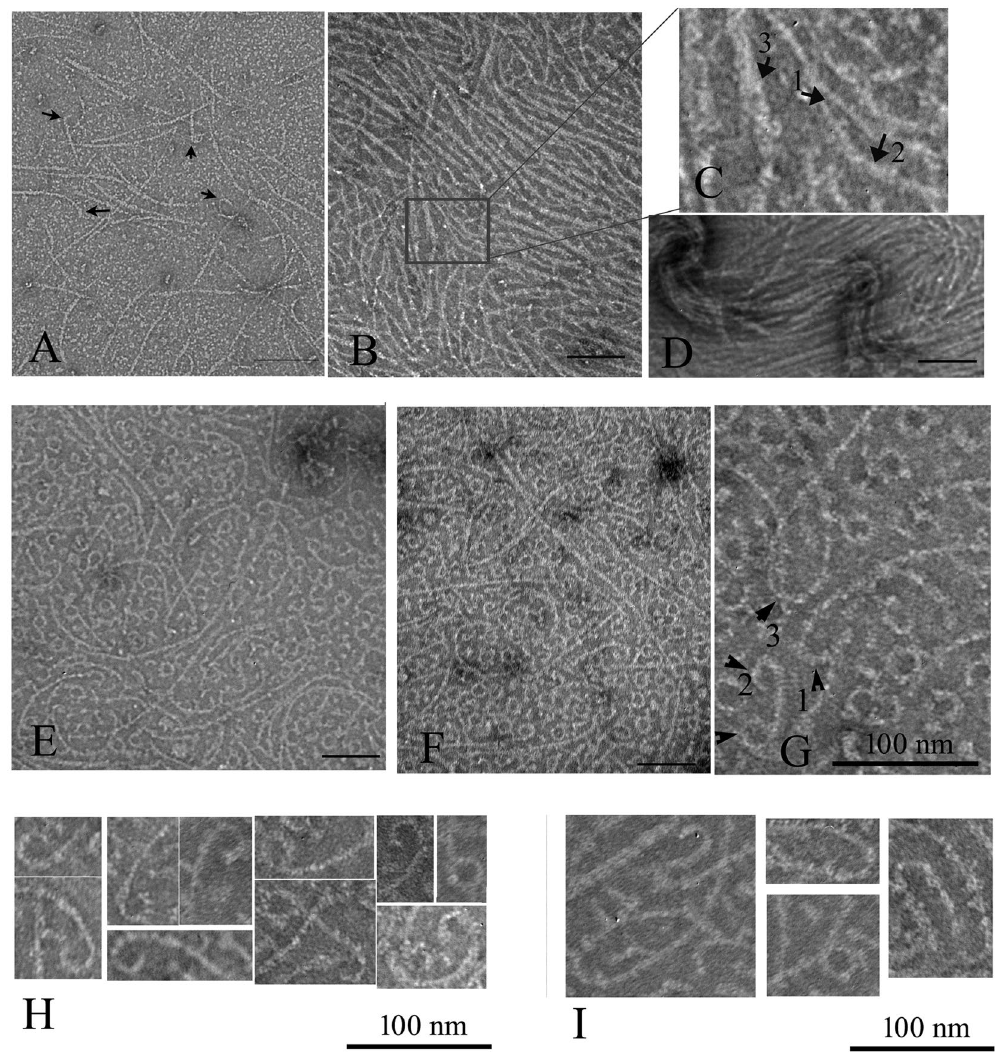
Figure 1. Electron microscopy (EM) images of FtsZ-ZipA at pH 6.5 and 7.5. ( A ) 5 µ M FtsZ only, at pH 7.5. Polymers are mostly single straight filaments, with some short curved segments at the ends (arrows). ( B – E ) At pH 6.5, 5 µ M FtsZ plus 5 µ M ZipA assembles mostly into bundles ( B – D ). In ( C ) arrows identify FtsZ single filaments (arrow 1) and FtsZ-ZipA bundles of variable thickness (arrow 2 and 3). Some areas show single filaments mixed with highly curved filaments and minirings ( E ). ( F – G ) At pH 7.5, 5 µ M FtsZ plus 5 µ M ZipA assembles into single filaments and bundles, mixed with many highly curved filaments and minirings. The highly curved filaments locate mostly at the end of filaments (G, arrow 1), sometimes at both ends ( G , arrow 2), or rarely in the middle of the filaments ( G , arrow 3). ( H – I ) Selected EM images of the highly curved filaments at the end of filaments ( H ) or in the middle of filaments ( I ). Bars represent 100